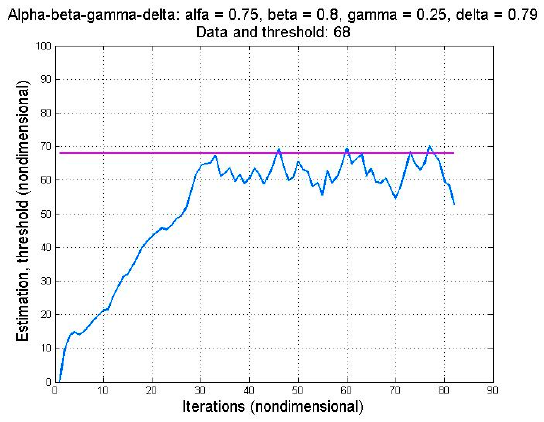
Figure 15. The α – β – γ – δ filter succeeds in exceeding the threshold value of 68.